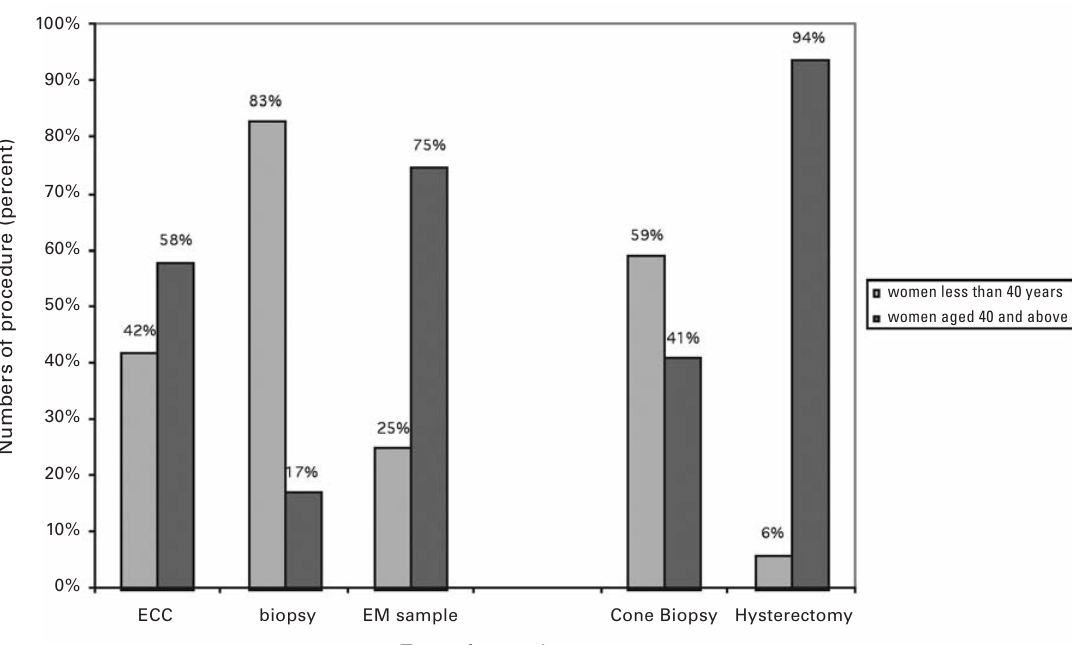
Investigations in women aged below 40 (N = 38) and aged 40 and above (N = 65) with cytodiagnosis of